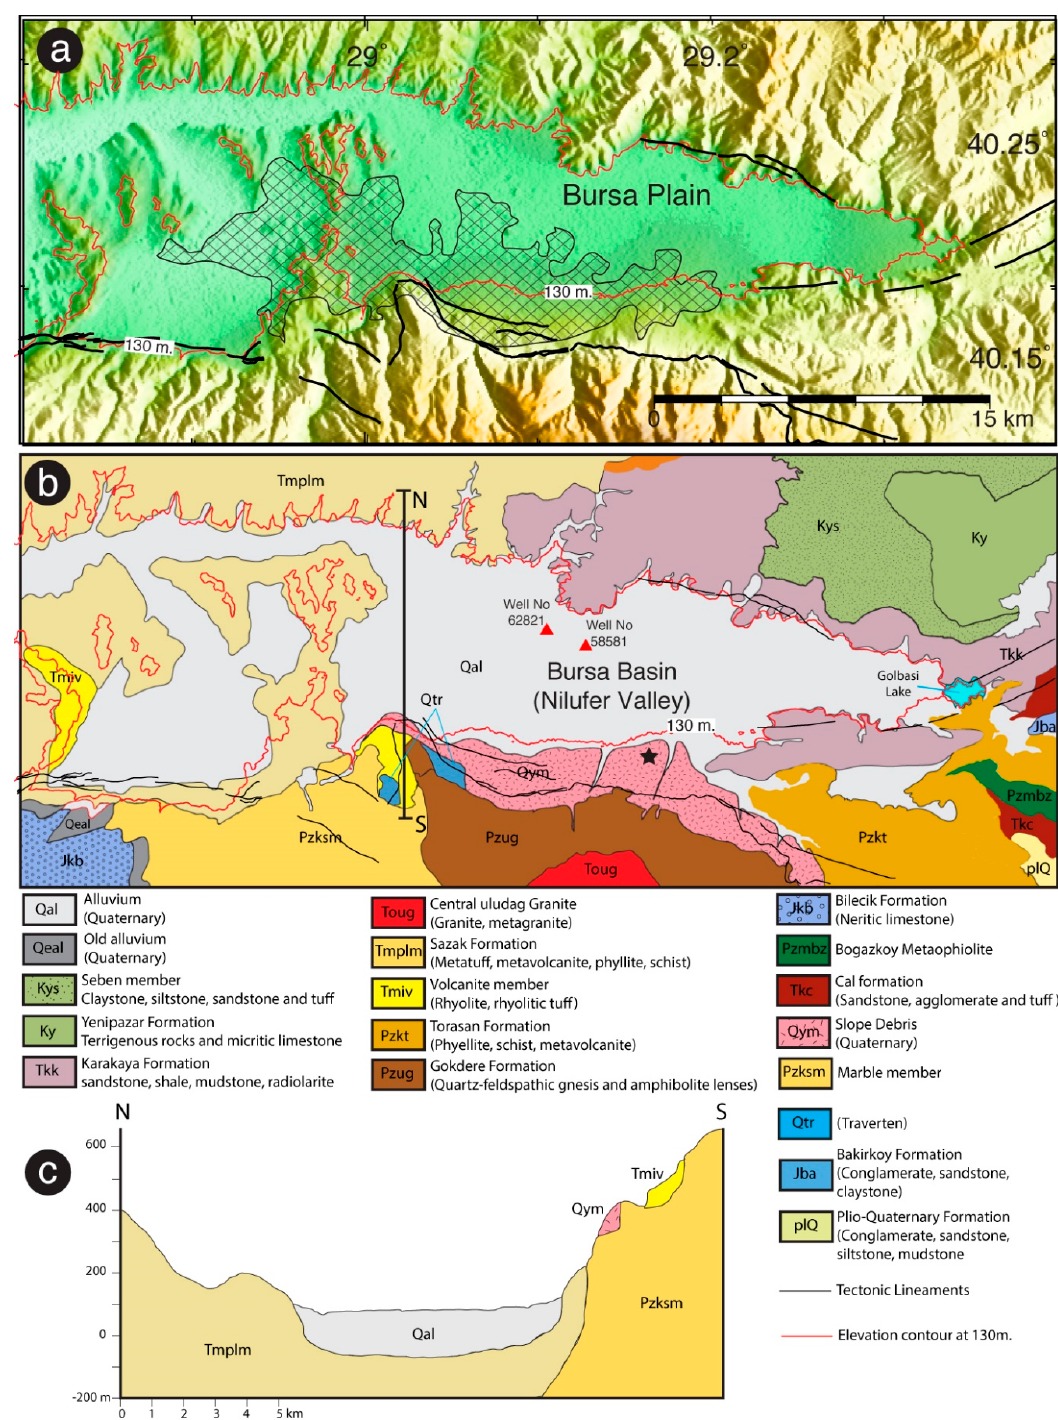
Figure 2. ( a ) Topographic view of the Bursa Plain. Elevation contour at 130 m surrounding the Bursa Plain is shown in red solid lines and major active faults in solid black lines [57]. The shaded area shows the extent of urbanization for Bursa. ( b ) Geological map of the study area simplified from MTA—Turkey General Directorate of Mineral Research and Exploitation 1/100,000 scale geology map. Red triangles show the locations of wells (well #58581 and #62821). Black star shows the area to which InSAR velocities are referenced. ( c ) North-south geological cross section of the Nilufer Valley from [52]; see profile location on Figure 2b.